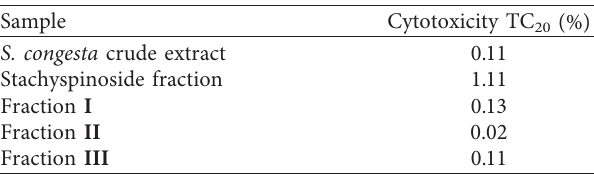
Figure 5: (a) Chromatogram of CPC fractionation of the aqueous extract from S. congesta in descending mode. Solvent system: terAcWat +1; sample concentration 2mg/mL; detection wavelength 260nm; flow rate: 30mL/min; rotor speed: 1500rpm; retention of stationary phase: 62.5%; retention time of fraction I (8–12min); and retention time of fraction II (18–26min). (b) Chromatogram of CPC fractionation of the aqueous extract from S. congesta in ascending mode. Solvent system: terAcWat +1; sample concentration 2mg/mL; detection wavelength 260nm; flow rate: 30mL/min; rotor speed: 1500rpm; retention of stationary phase: 70.5%; and retention time of fraction III (1.5–15min). Table 2: Cytotoxicity of S. congesta crude extract and CPC fractions on HEK